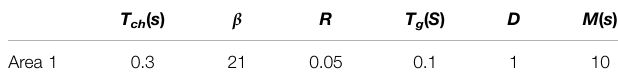
TABLE 2 | Parameters of one-area LFC system.